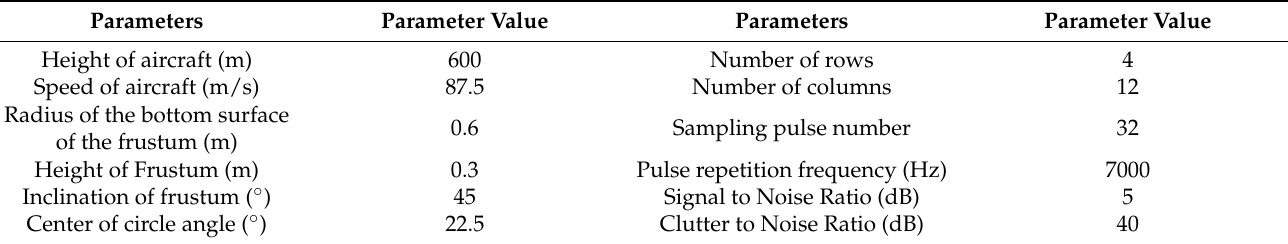
Table 1. Aircraft and radar simulation